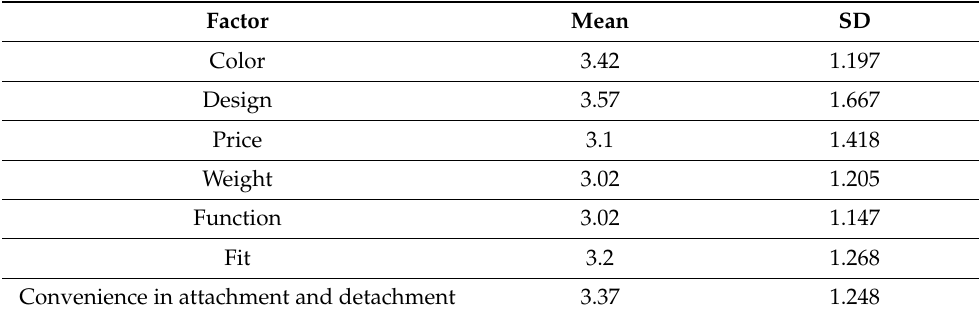
Table 6. Satisfaction with the prosthetic upper limb ( n = 55).